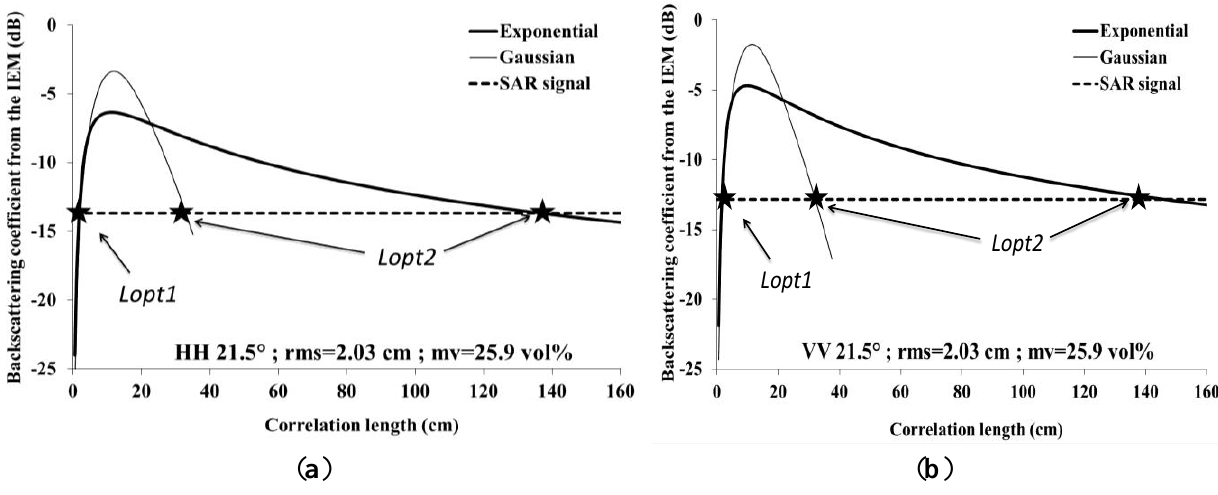
Figure 3. Behaviour of the IEM as a function of correlation length for a given plot, with Gaussian and exponential ACFs. ( a ): HH polarization, ( b ): VV polarization.